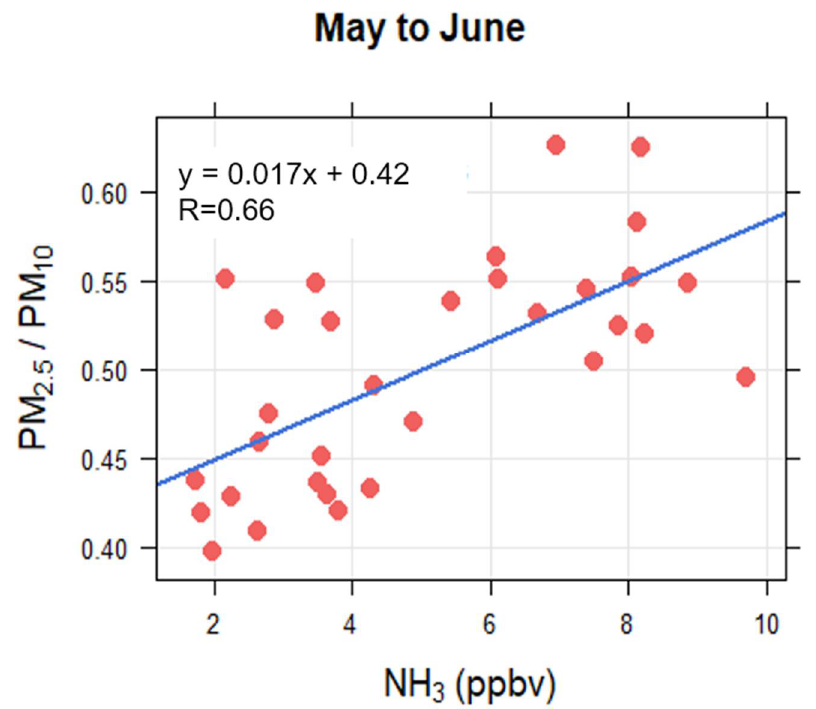
Figure 6. Scatter plots representing the correlation between PM 2.5 /PM 10 ratio and CrIS NH 3 over the SMA from May to June, when secondary PM formation was increasing. The data were prepared from monthly means at a 15 km resolution (shown in Figure 3).